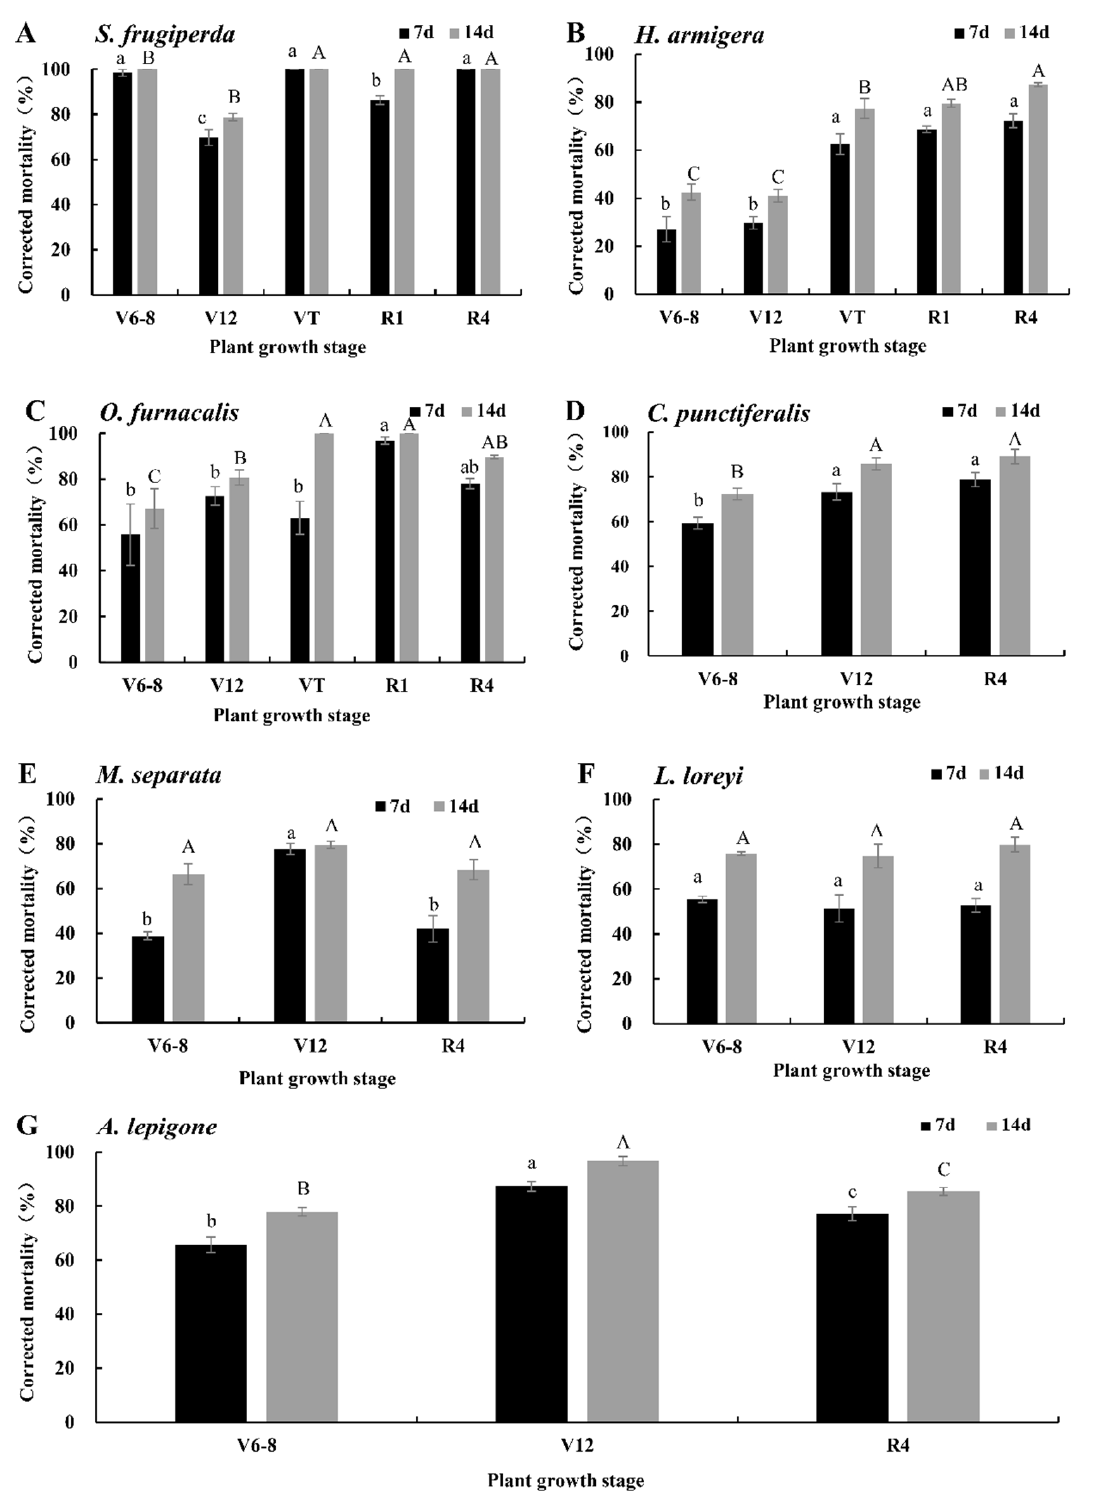
Figure 4. Corrected mortalities of neonates for seven lepidopteran pests on artificial diet containing lyophilized different tissues of MIR162 corn (expressing Vip3Aa) in different growth stages at a 25-fold dilution relative to the isogenic negative control. Values represent means ± SE. Different lowercase and uppercase letters above black and gray bars indicate significant difference for the same treatment time by Duncan’s multiple range test ( p < 0.05). ( A ) S. frugiperda ; ( B ) H. armigera ; ( C ) O. furnacalis ; ( D ) C. punctiferalis ; ( E ) M. separata ; ( F ) L. loreyi ; and ( G ) A. lepigone.